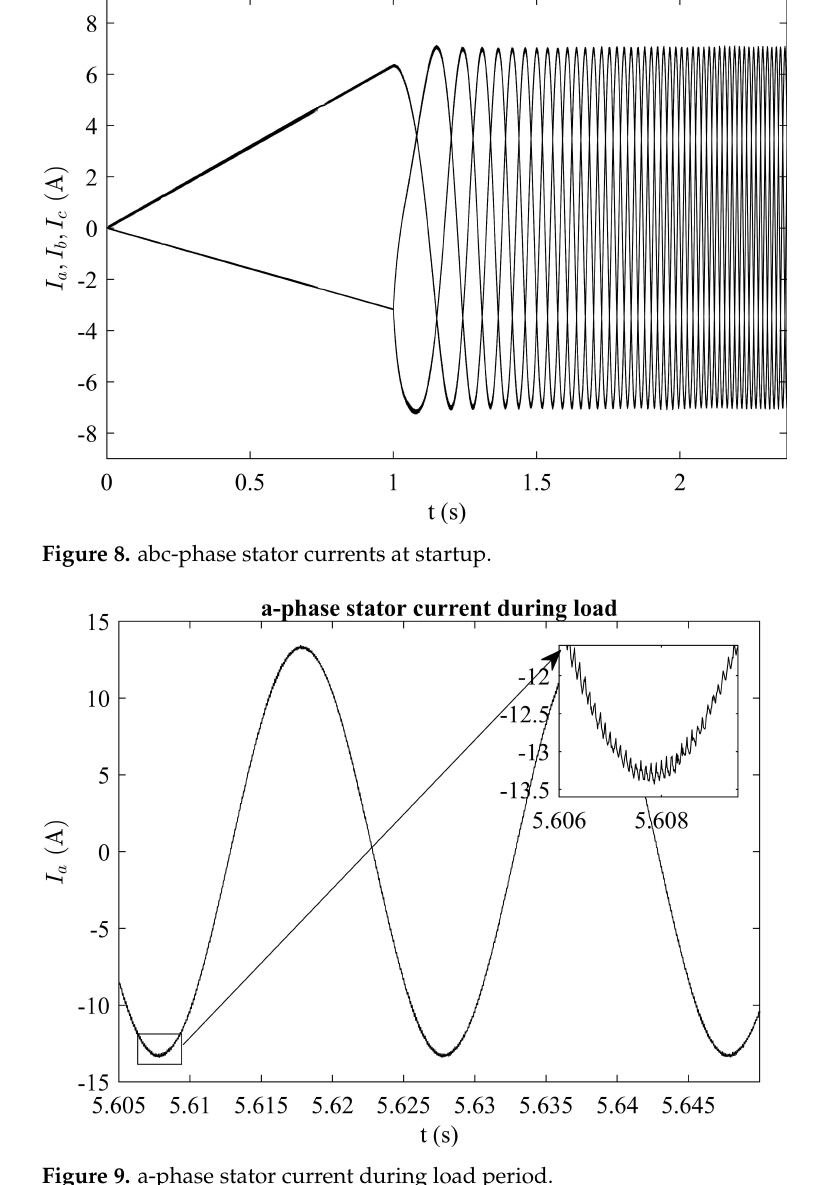
Figure 9. a-phase stator current during load